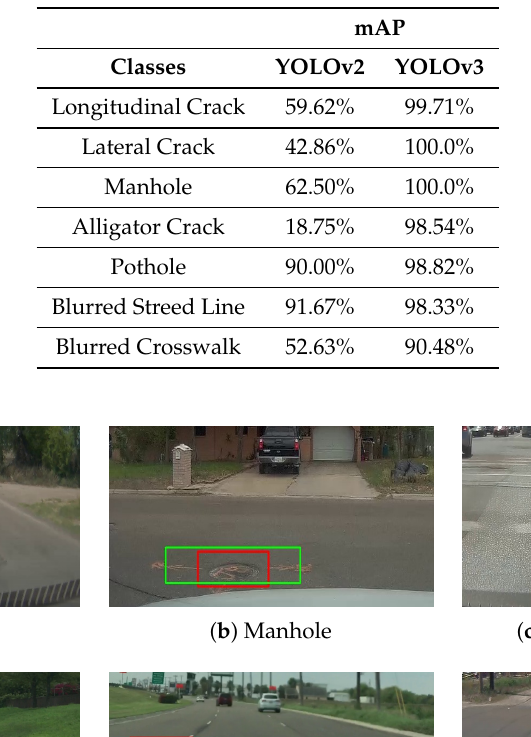
Figure 4. Distribution of train + test labels used in our detector’s training and evaluation (test images were not included at the time of training). Table 2. Mean Average Precision (mAP) per class for both detectors, and they were tested using the same number and distribution of training and testing images.